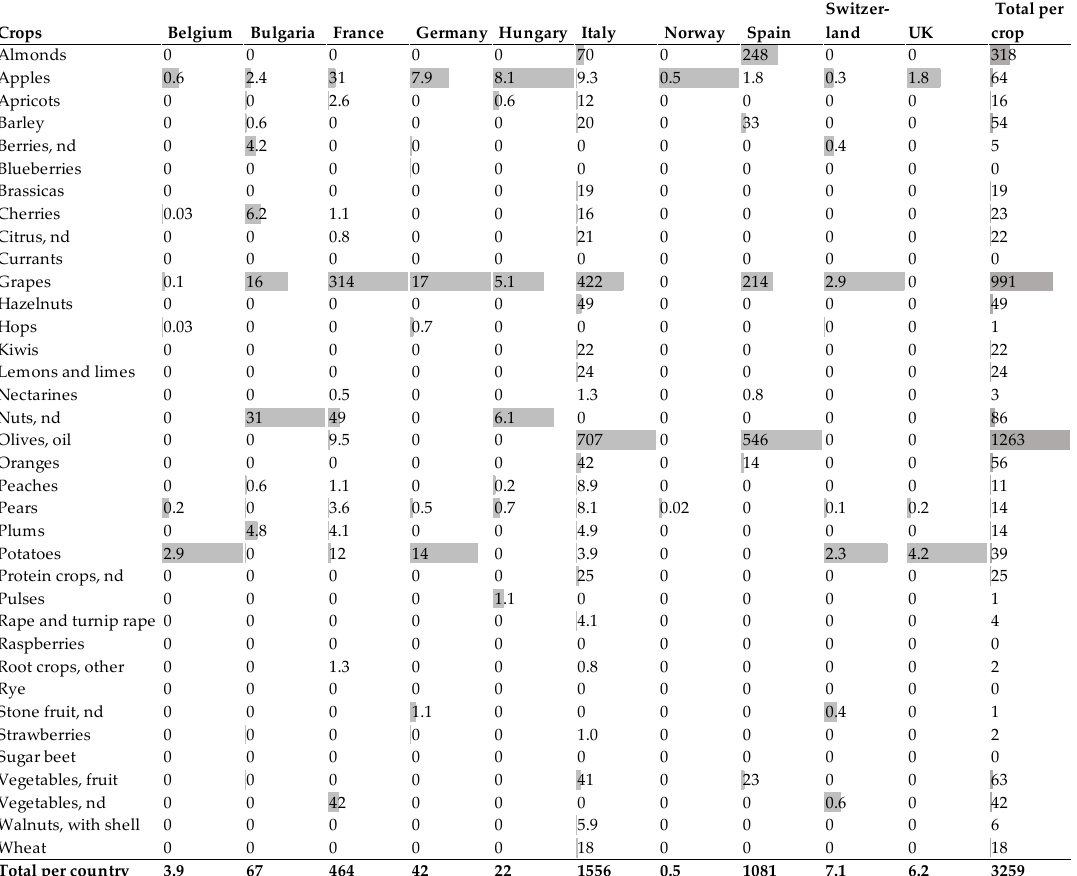
Figure 3. Total estimated copper consumption (t y − 1 ) in organic farming in the 12 surveyed European countries in different horticultural crops (temperate fruits; grapes; olives; nuts; and vegetables, including potatoes). Gray bars visualize the relative contribution of a crop to overall copper consumption in an individual country.